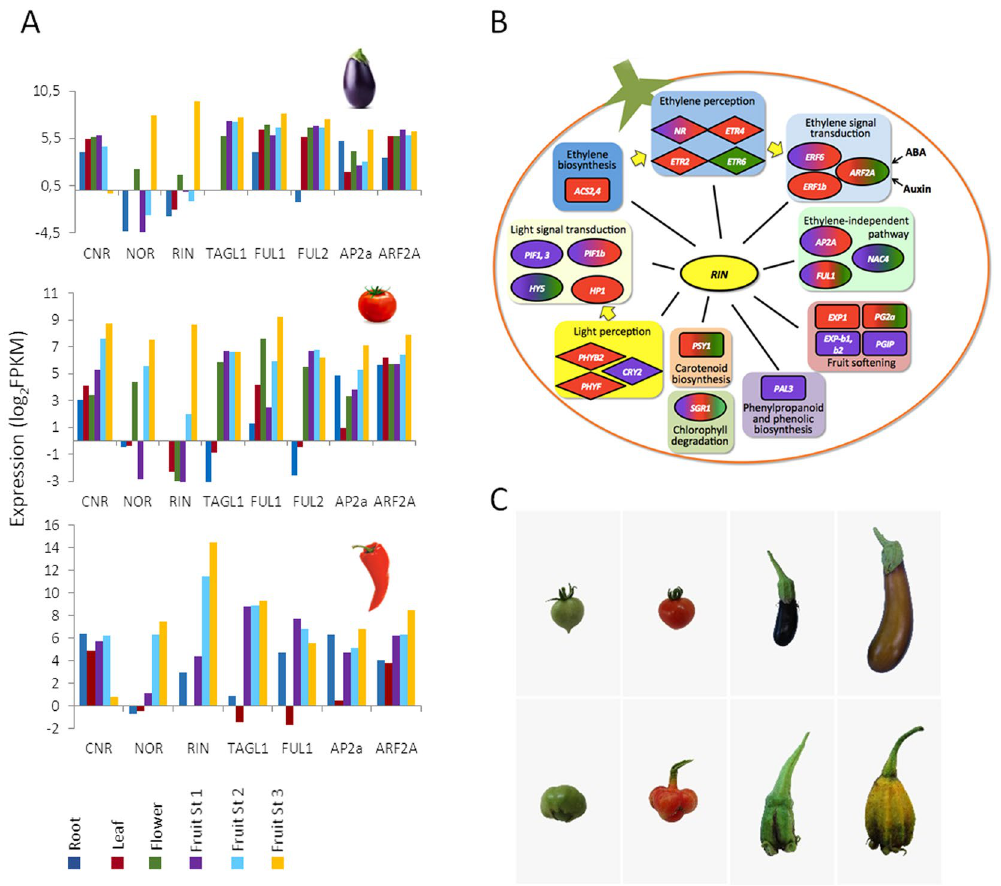
Figure 4. Evolution of fruit ripening control in the Solanaceae. ( A ) Expression (log 2 FPKM) of ripening transcription factor regulators CNR , NOR , RIN , TAGL1 , FUL1/2 , AP2a and ARF2A in different tissue types (root, leaf and flower) plus different stages of fruit ripening (stage 1, stage 2 and stage 3) of eggplant (upper panel), tomato (middle panel) and pepper (lower panel). ( B ) Co-expression (R-value ≥ 0.8) of ripening -related genes with the RIN ripening regulator; ellipses, diamonds and rectangles indicate, respectively, transcription factor-, receptor-, and enzyme-encoding genes; purple, red and green shading indicate, respectively, co- expression with RIN in eggplant, tomato and pepper. Detailed co-expression values are shown in Supplementary Table S31. ( C ) Wild-type tomato fruit at two stages of ripening (upper left two panels); wild-type eggplant fruit at two stages of ripening (upper right two panels); and over-expression of the TOMATO AGAMOUS-LIKE 1 ( TAGL1 ) gene in tomato fruit at two ripening stages (lower left two panels) and in eggplant fruit at two ripening stages (lower right two